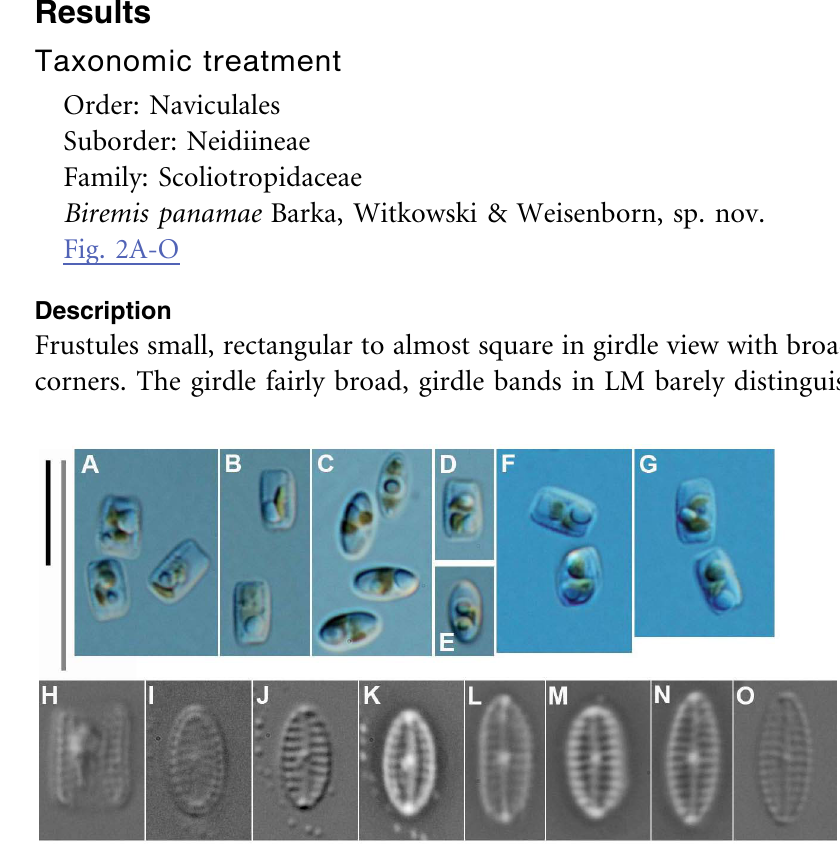
Figure 2. Biremis panamae sp. nov., living cells and cleaned valves under LM. A–G . Living specimens photographed from the clonal culture. Note the two chloroplasts per cell. H–O . Cleaned material from the clonal culture. Fig. 2H–J were taken with advanced photomicroscopy system; Fig. 2K–N. were taken with phase contrast optics; Fig. 2O. was taken with differential interference contrast (DIC). Fig. 2H is a frustule in girdle view; Fig. 2I–O are valves in valve view. [Scale bars 5 10 m m; the grey bar only for Figures